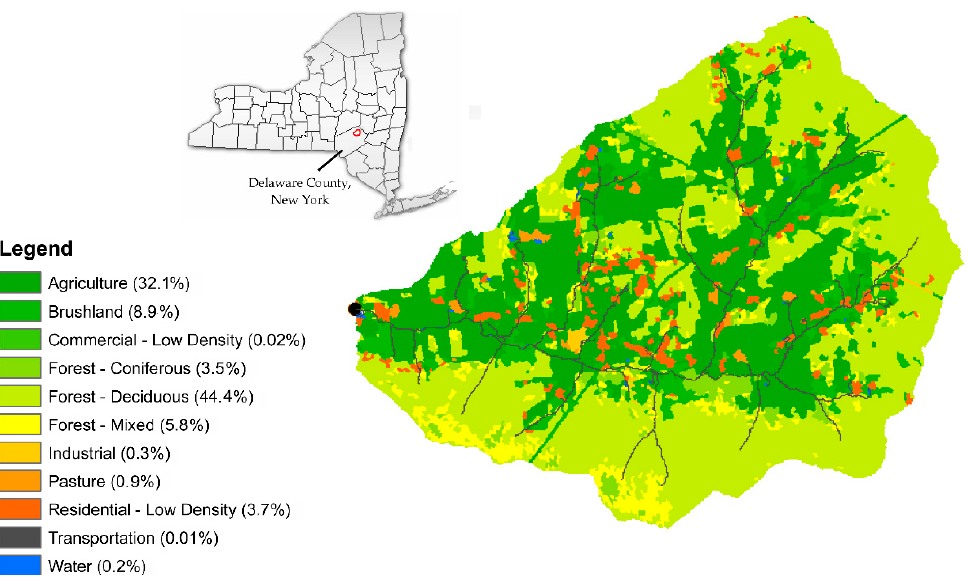
Figure 2. Location of the Town Brook watershed and its land use.